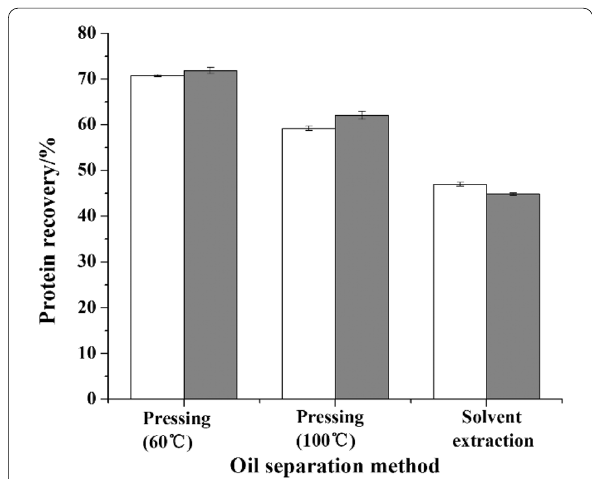
Fig. 5 Effect of extraction time on protein recovery. ( ) Protein extractions performed at 25 ℃ for 1 h; ( ) Protein extractions performed at 25 ℃ for 6 h